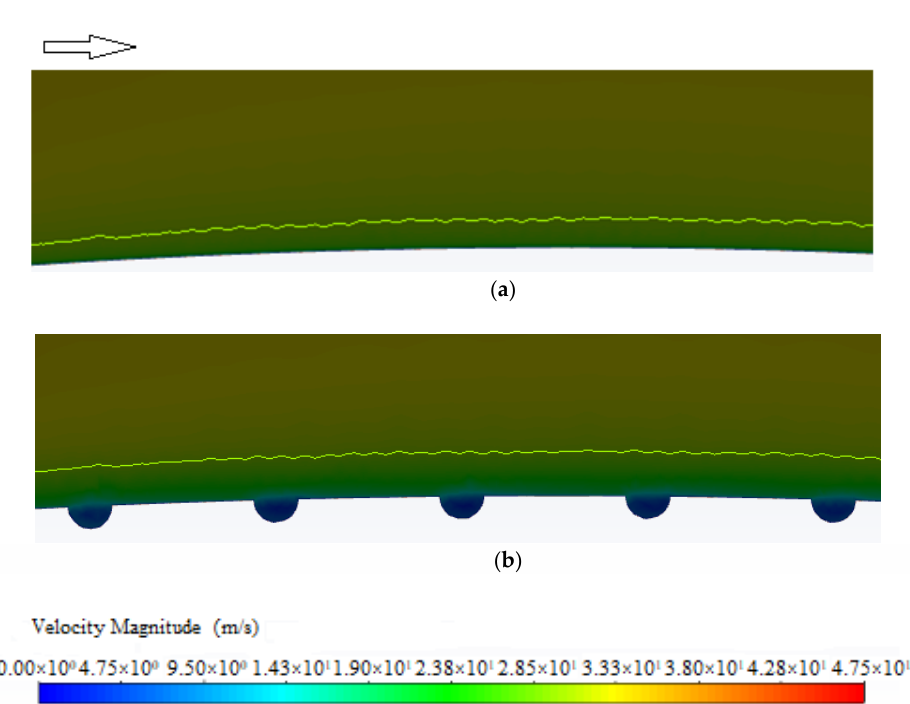
Figure 10. Velocity vector inside the circular concave .